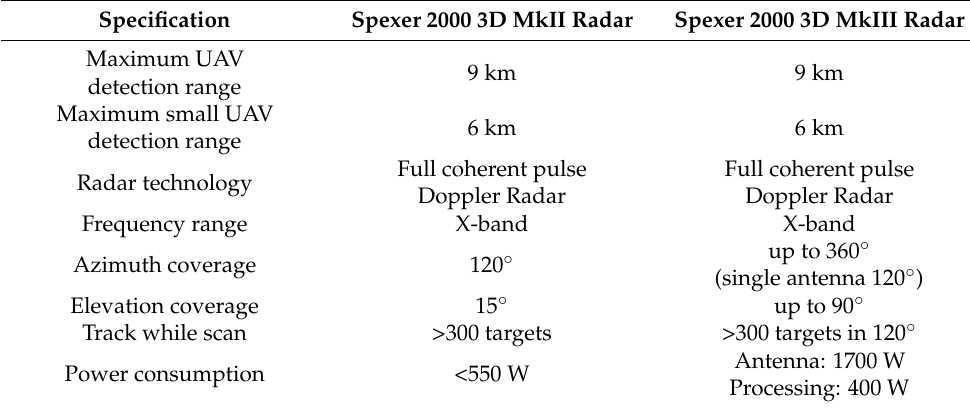
Table 3. HENSOLDT radar